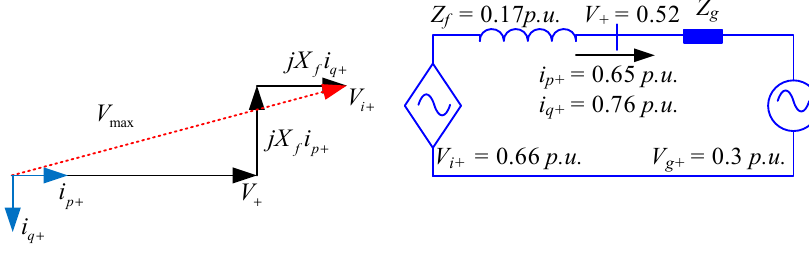
Figure 4 . Vector representation of voltages and currents of GC-VSC working at normal grid conditions or balanced voltage changes while injecting reactive power.